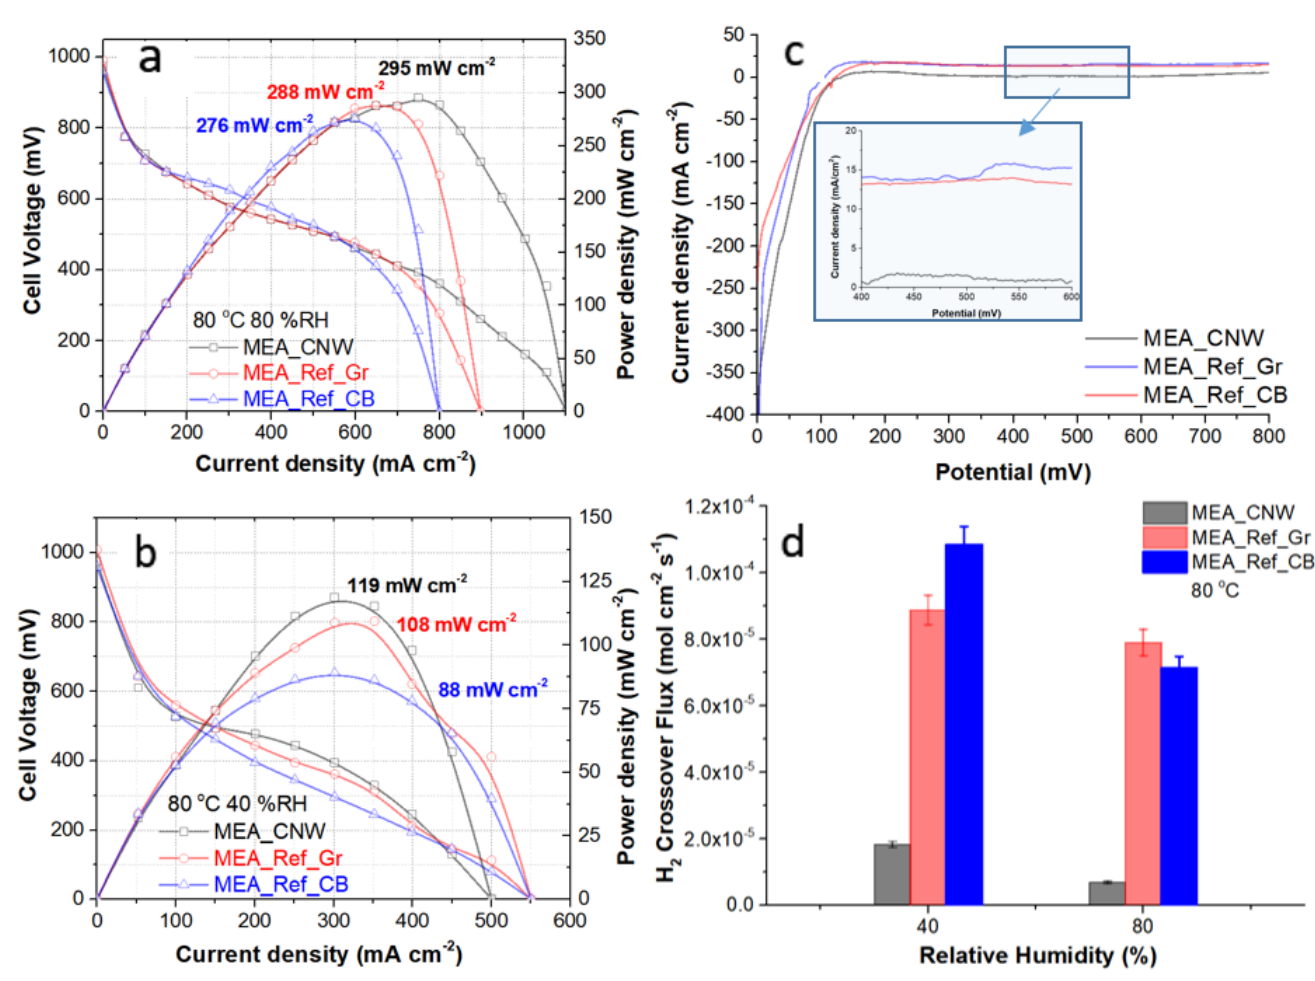
Figure 8. Polarization curves of comparative I–V and power density profiles between the MEA_CNW and reference MEAs, MEA_Ref_Gr and MEA_Ref_CB at 80 ◦ C and 80% relative humidity ( a ) and at 80 ◦ C and 40% relative humidity ( b ), respectively, with peak power densities given next to the corresponding profiles. In situ polarization testing was performed at 70 kPa of overall pressure in current sweep mode at constant flow rates of 200 SCCM of hydrogen at the anode and 800 SCCM of air at the cathode. ( c ) Hydrogen crossover testing by in situ linear sweep voltammetry for MEA_CNW, MEA_Ref_Gr, and MEA_Ref_CB at 80 ◦ C and relative humidity of 80%; ( d ) hydrogen crossover comparative results for tested MEAs at 80 ◦ C and relative humidities of 40% and